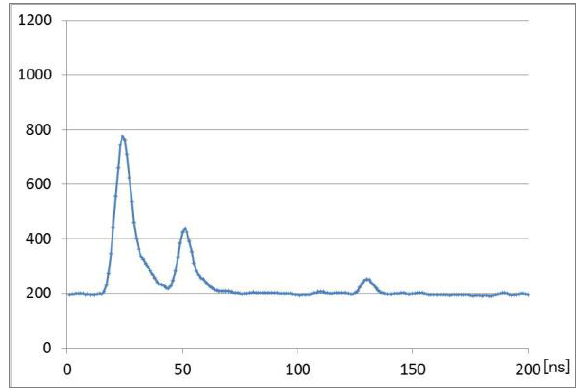
Figure 4. Waveform of reeds